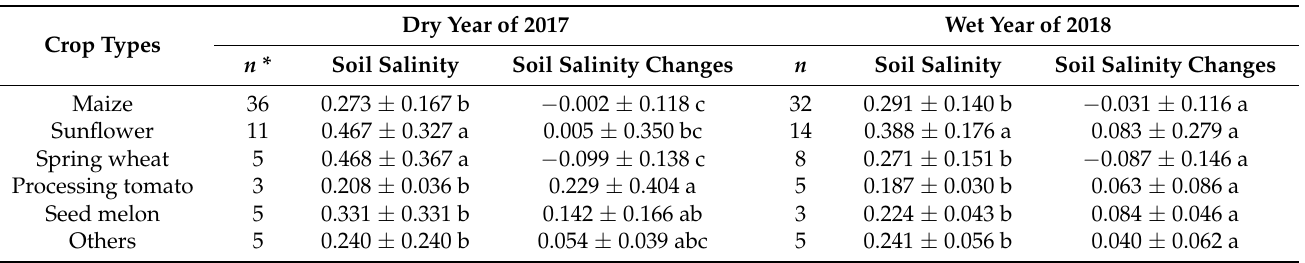
Table 4. Root zone soil salinity under different crop types in early May and its change in the crop growing season